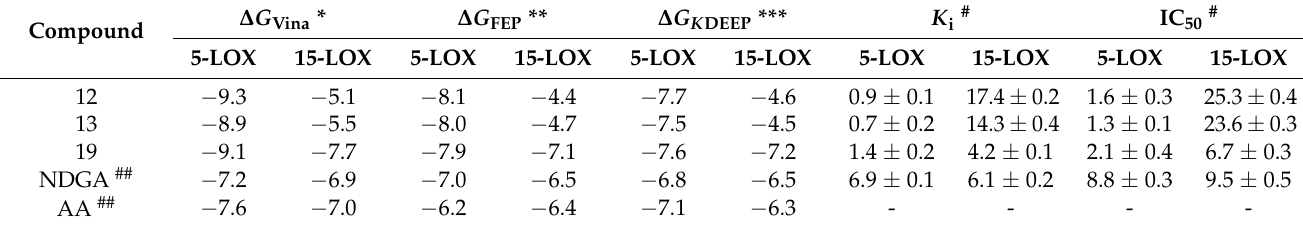
Table 3. Docking scores, binding free energies, K i and IC 50 values of compounds 12 , 13 , and 19 together with the co- crystallized inhibitors NDGA and